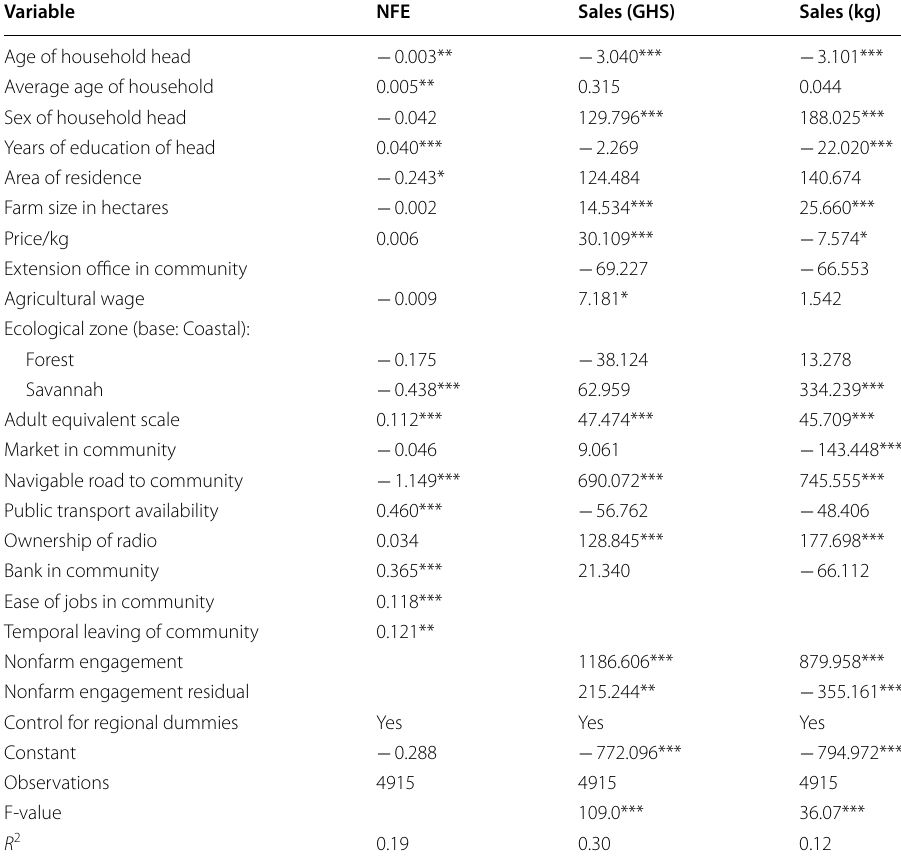
Table 6 Effect of NFE on sales value and sales